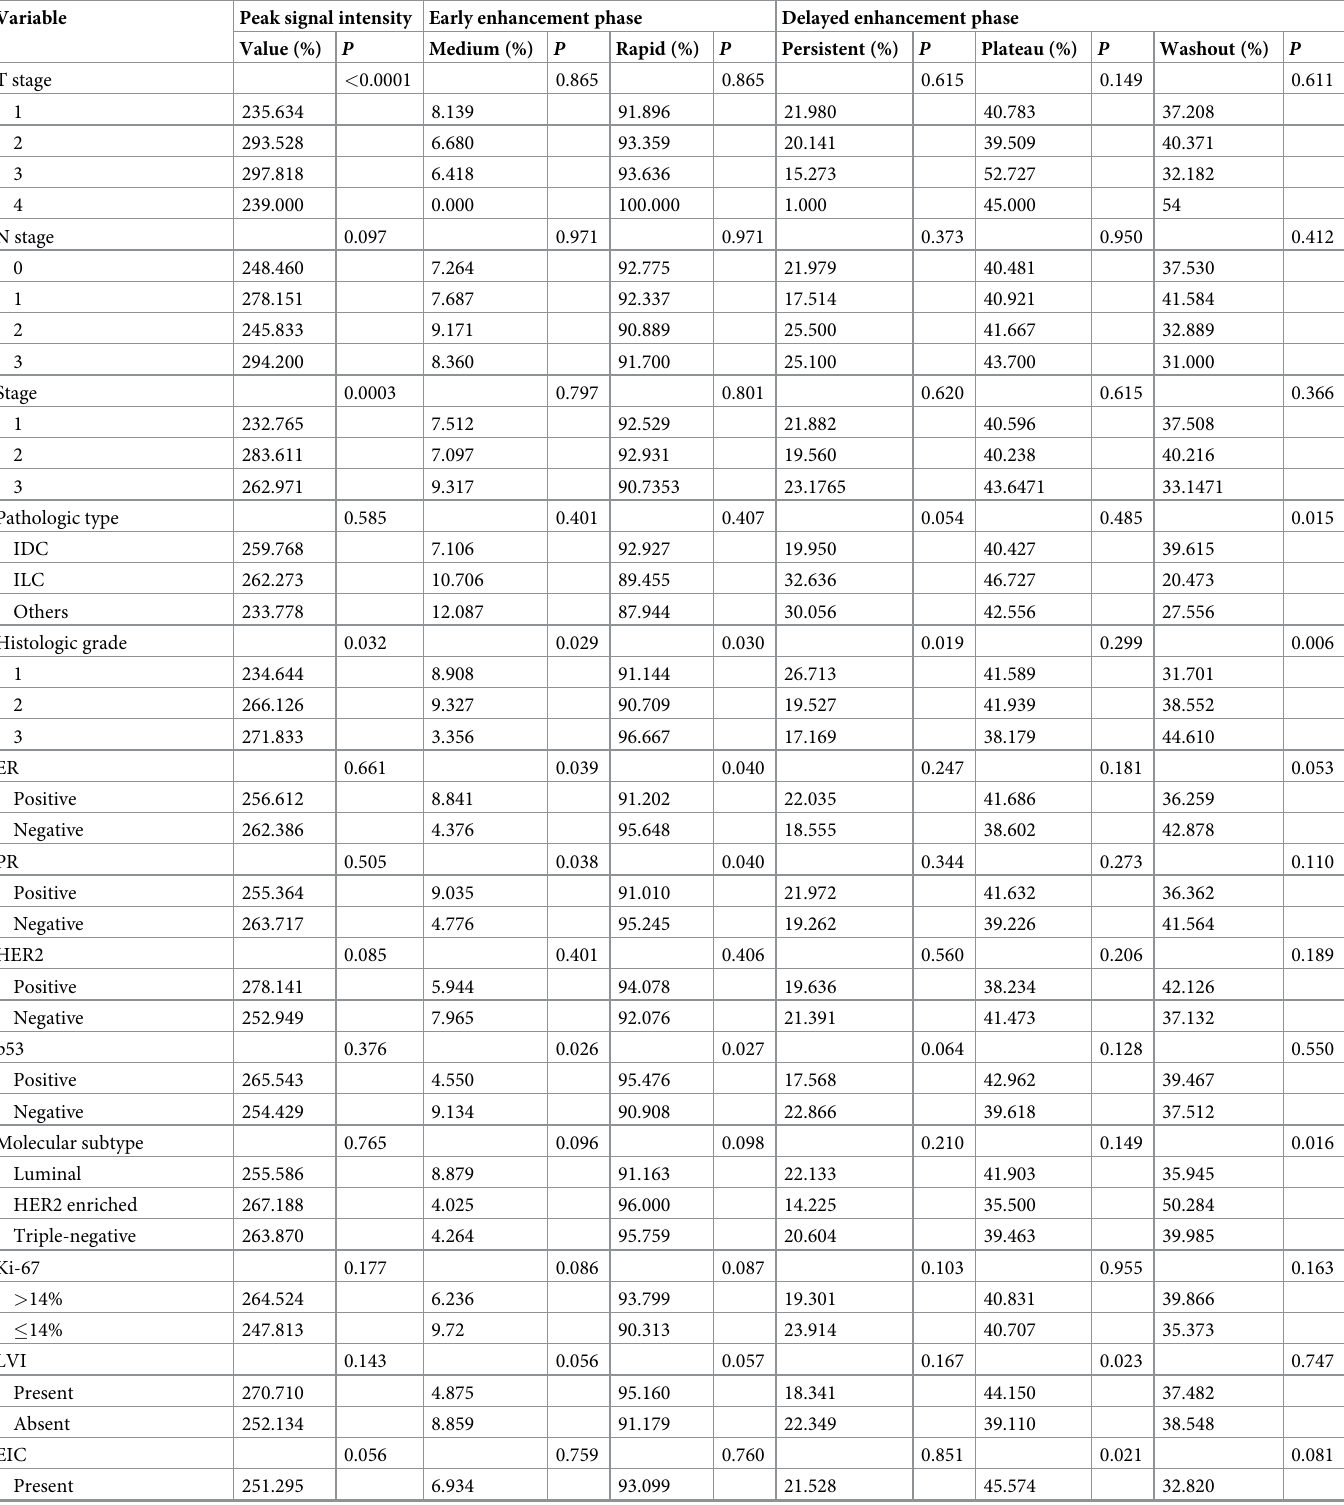
Table 4. Relationship between MR imaging kinetic features and various clinicopathological